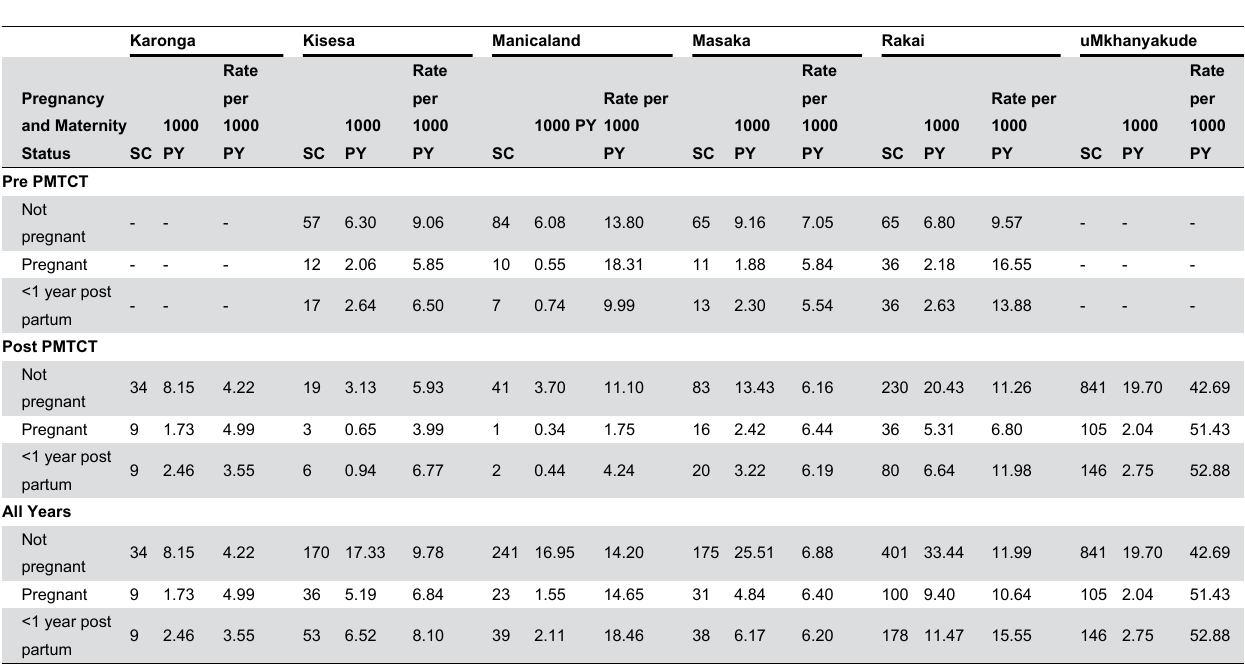
Table 3. Number of Sero-conversions (SC) and person years (PY) contributing to the analysis for each site by period (mean of imputation runs).